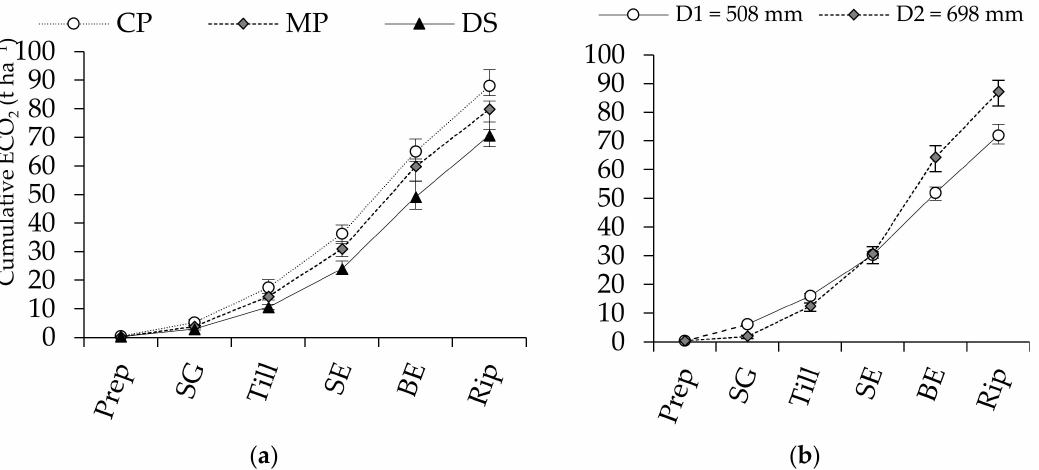
Figure 4. ( a ) Effect of Soil Preparation; ( b ) Effect of Irrigation Depth; ( a , b ) Cumulative CO 2 efflux (Cumulative ECO 2 (t ha − 1 )) across the stages of development of irrigated wheat with varying soil preparation methods and irrigation depths, Tangar á da Serra, 2012; SG = Seedling Growth; Till = Tillering; ST = Stem Elongation; BE = Booting Emergence; Rip =